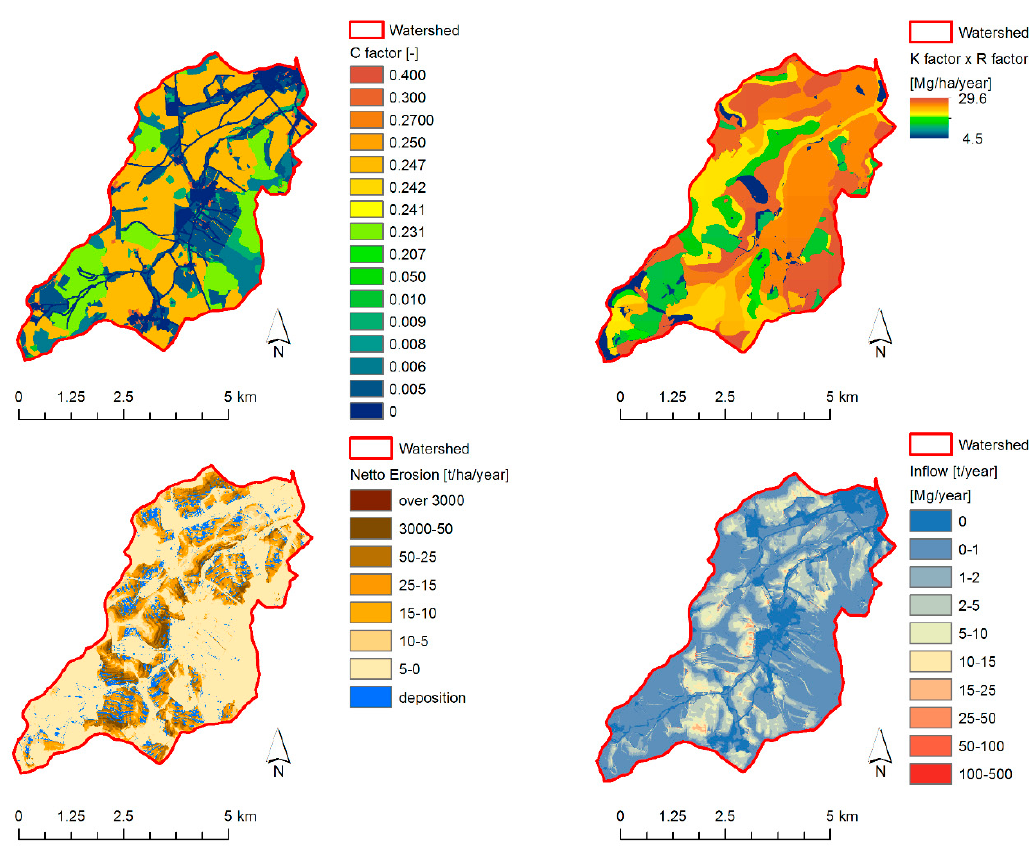
Figure 1. The example of data input (distributed C-factor, K-factor, and R-factor) and WaTEM/SEDEM outputs (netto erosion and inflow).